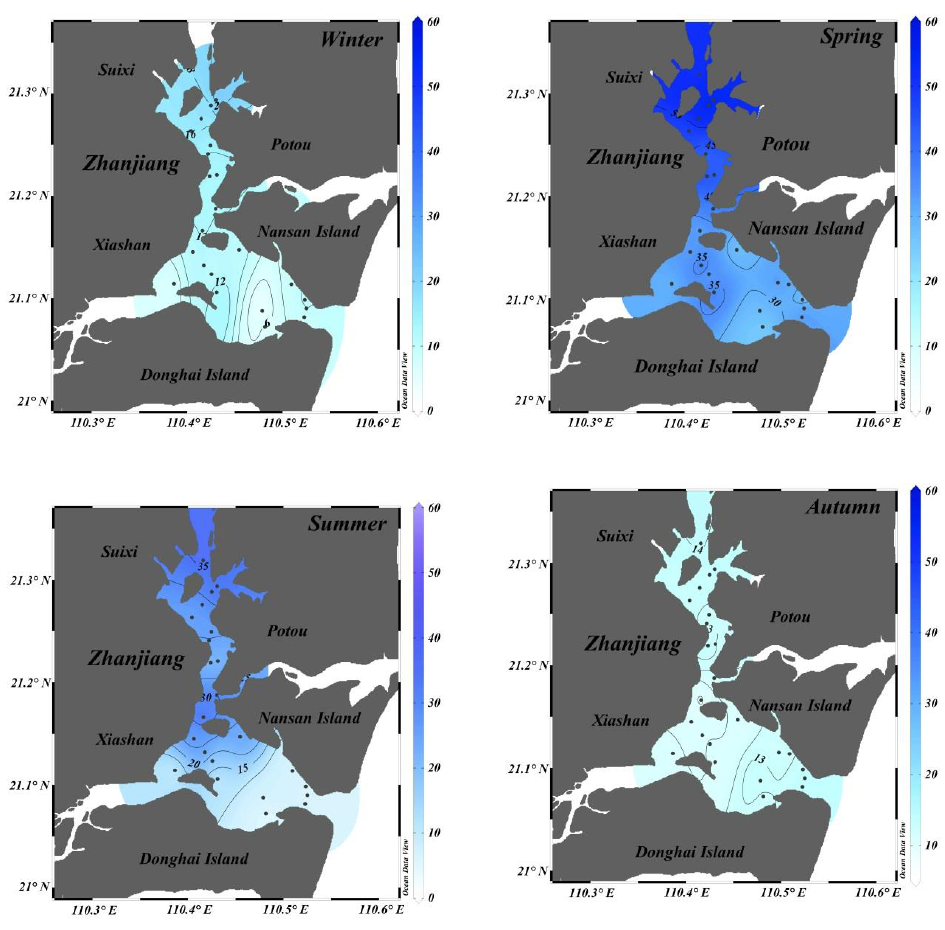
Figure 2. Spatiotemporal dissolved silicate (DSi) distribution in the Zhanjiang Bay coastal